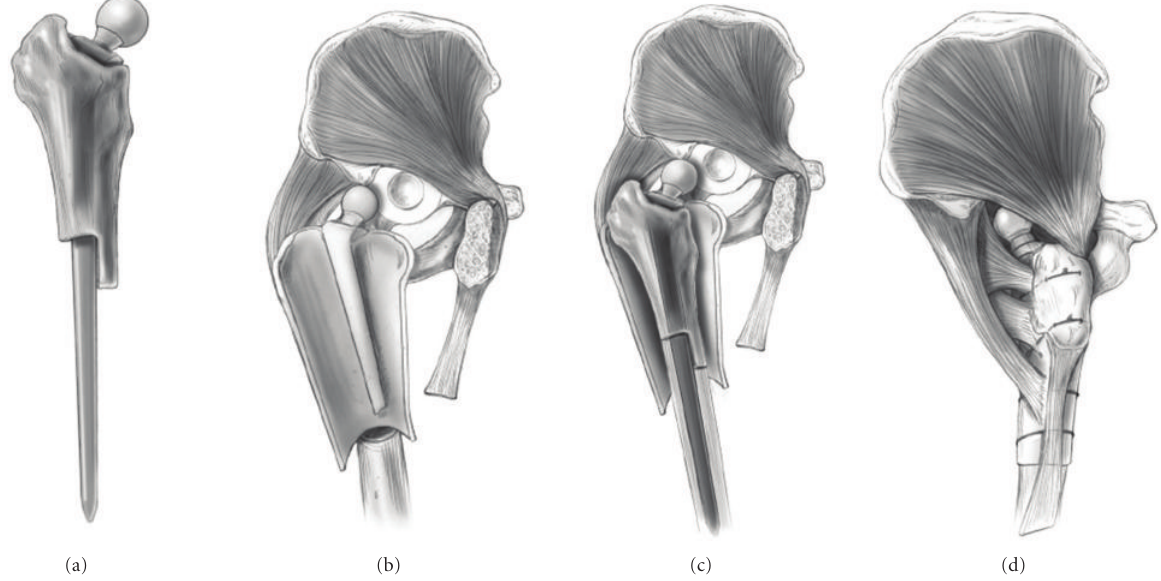
Figure 1: (a) Prosthesis cemented into allograft. (b) Trochanteric slide approach to hip, with lateral cortex osteotomy to facilitate removal of in situ femoral component. (c) Allograft-prosthesis composite inserted into host, with junctional step cut. (d) Remnants of host proximal femur are fixed around allograft, especially at the allograft-host junction, and the greater trochanter reattached.